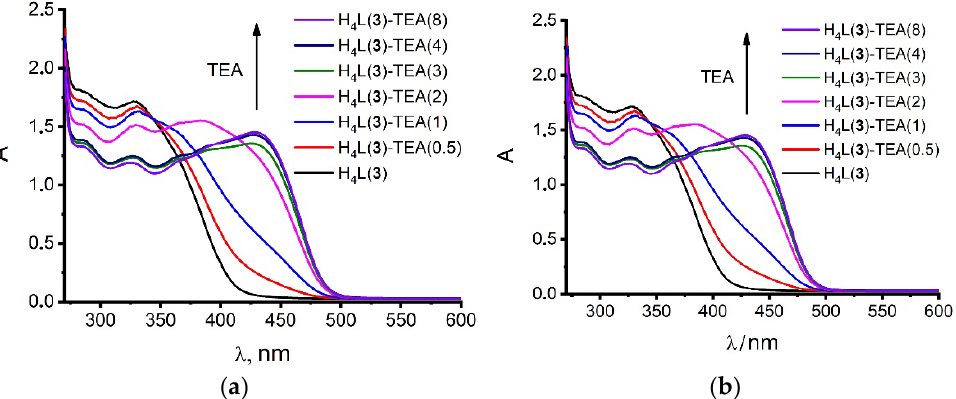
Figure 2. ( a ) UV–Vis spectra and ( b ) the absorbance values (A) (λ = 430 nm) in neutral and basified DMF solutions of H 4 L( 3 ) (C H4L = 0.05 mM) at the varied TEA/L (0–8) molar ratio. DMF solutions of H 4 L( 3 ) (C H4L = 0.05 mM) at the varied TEA/L (0–8) molar